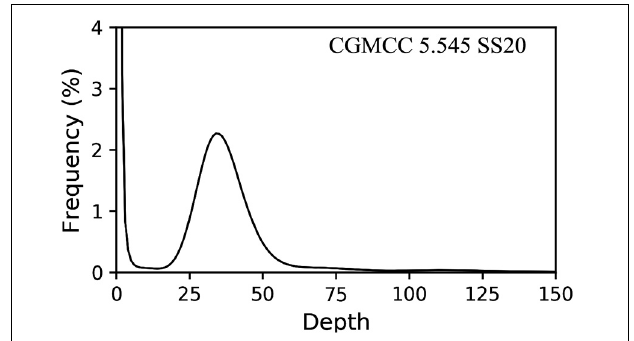
FIGURE 7 | Heterozygous ratio of homokaryon CGMCC 5.545 SS20.